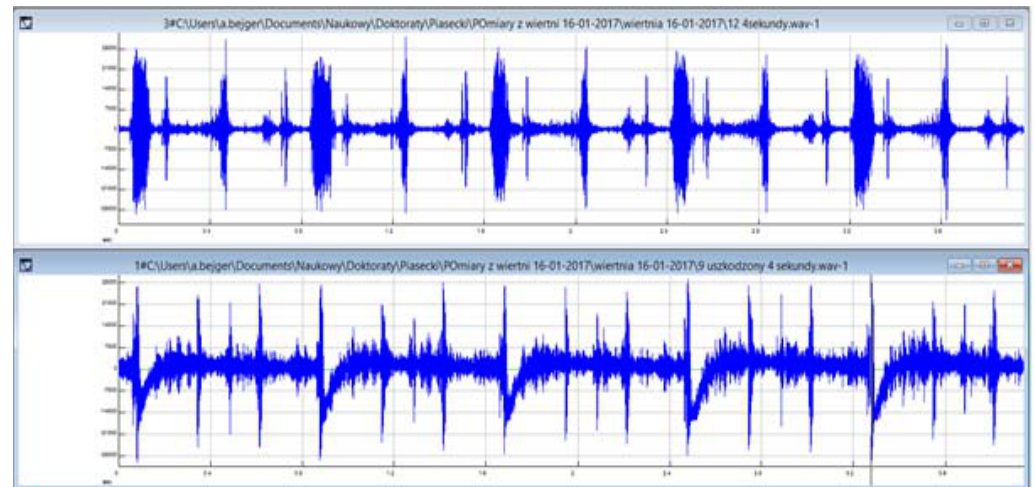
Figure 10. AE signal source from the running pump valves, with indicated stages of valve operation.